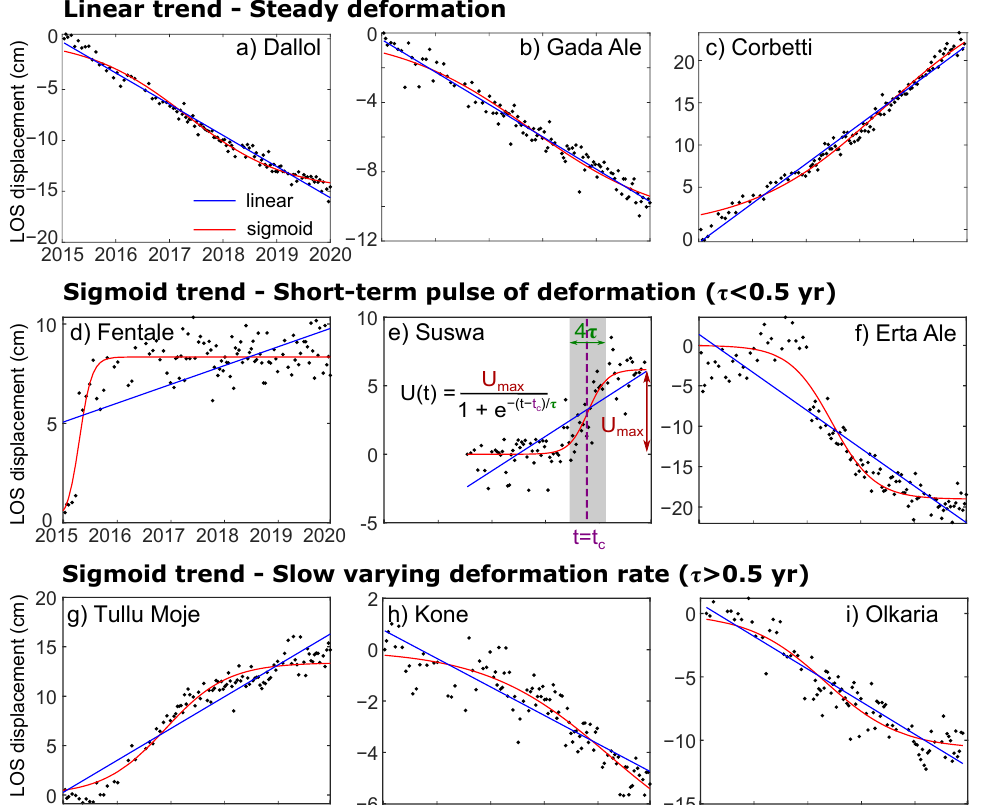
Figure 6. Examples of nine time series of LOS displacement showing the fit for the two functions: linear (blue) and sigmoid (red). Linear trend is preferred for the volcanoes ( a ) Dallol, ( b ) Gada Ale, and ( c ) Corbetti whereas sigmoid trend best fit for ( d ) Fentale, ( e ) Suswa, ( f ) Erta Ale, ( g ) Tullu Moje, ( h ) Kone and ( i ) Olkaria. Three volcanoes (Nabro, Alutu and Haledebi) do not fit either the linear or sigmoidal models ( R 2 < 0.5). All three can be described by a linear model superimposed with a seasonal signal (Figure S5 in Supplementary Materials). The amplitude of the seasonal signal, A s , is ∼ 3 cm for Nabro and ∼ 2 cm for Alutu and Haledebi (Table